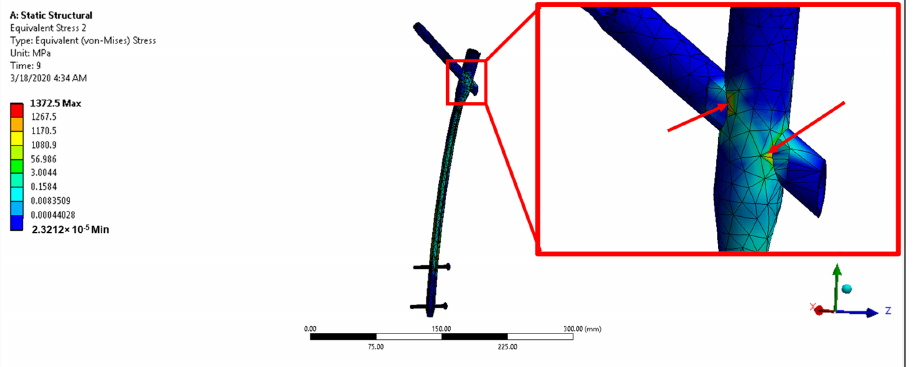
Figure 20. The von Mises stress distribution across the femoral bone fixed with CM nail. Figure 20 . The von Mises stress distribution across the femoral bone fixed with CM nail.